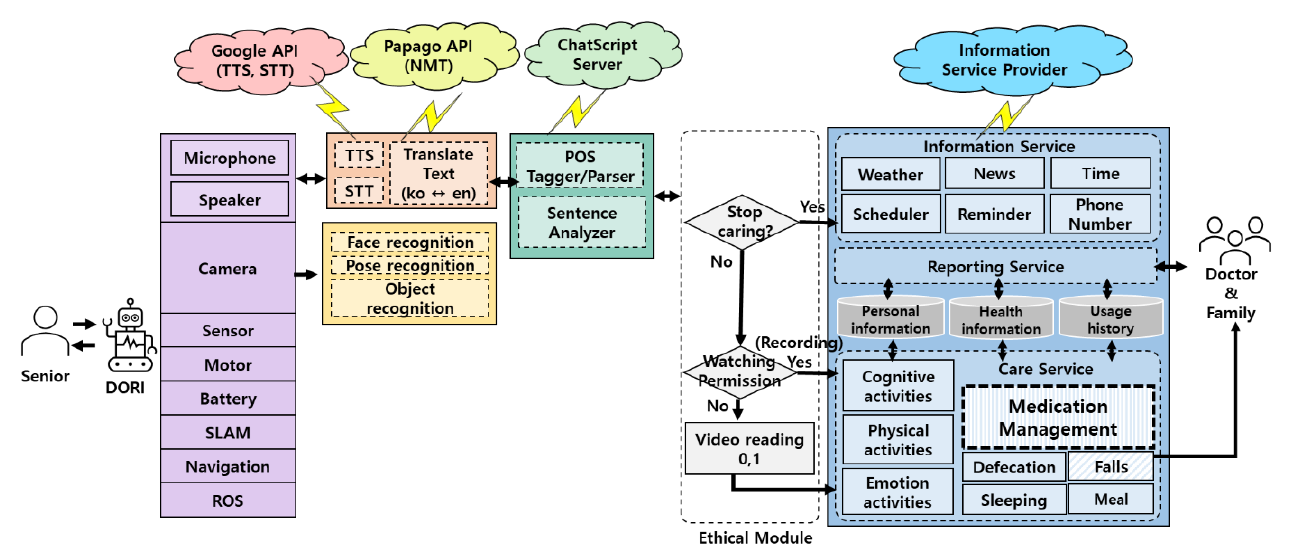
Figure 3. Software architecture of care robot Dori.